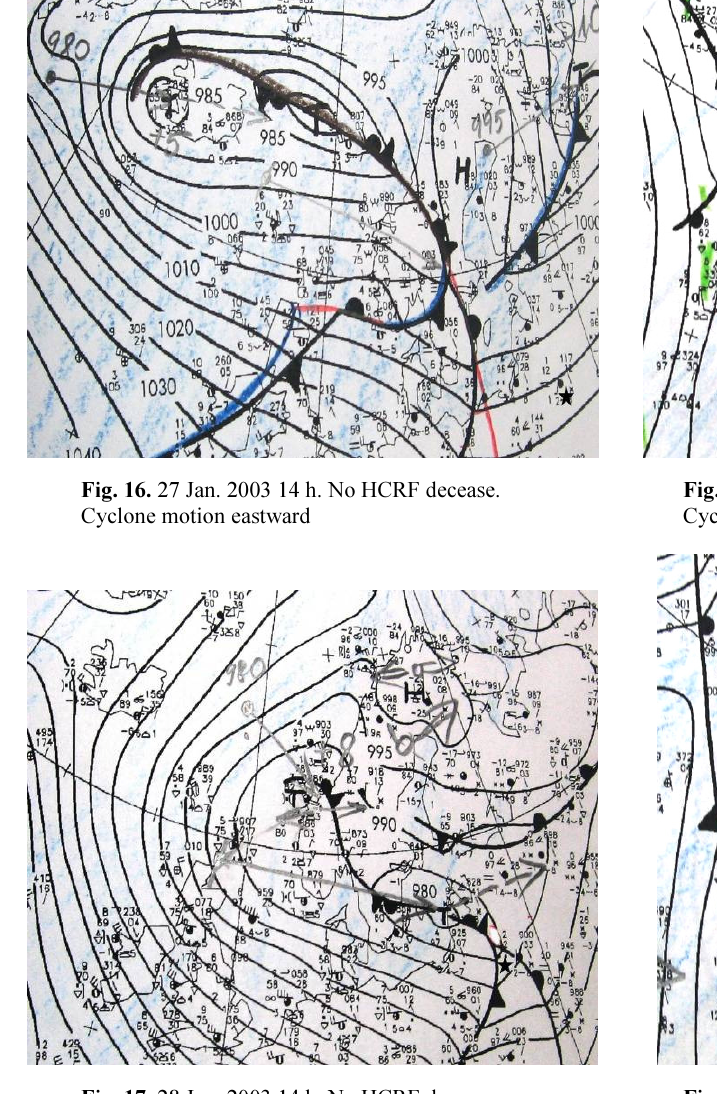
Fig. 17. 28 Jan. 2003 14 h. No HCRF decease. Fig. 19. 30 Jan. 2003 14 h. No HCRF decrease. Minimum Cyclone motion eastward atmospheric pressure formation (993 hPa) in Vilnius in 5–6 days after the first registration of HCRF decrease (Fig.